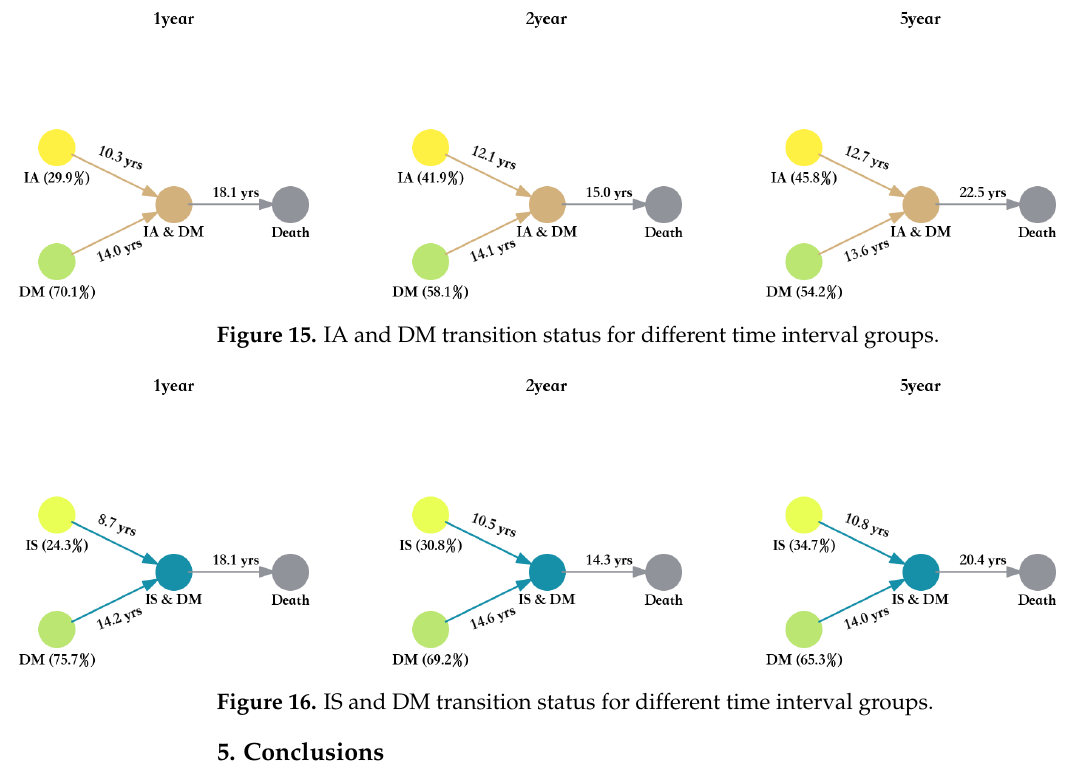
Figure 16. IS and DM transition status for different time interval